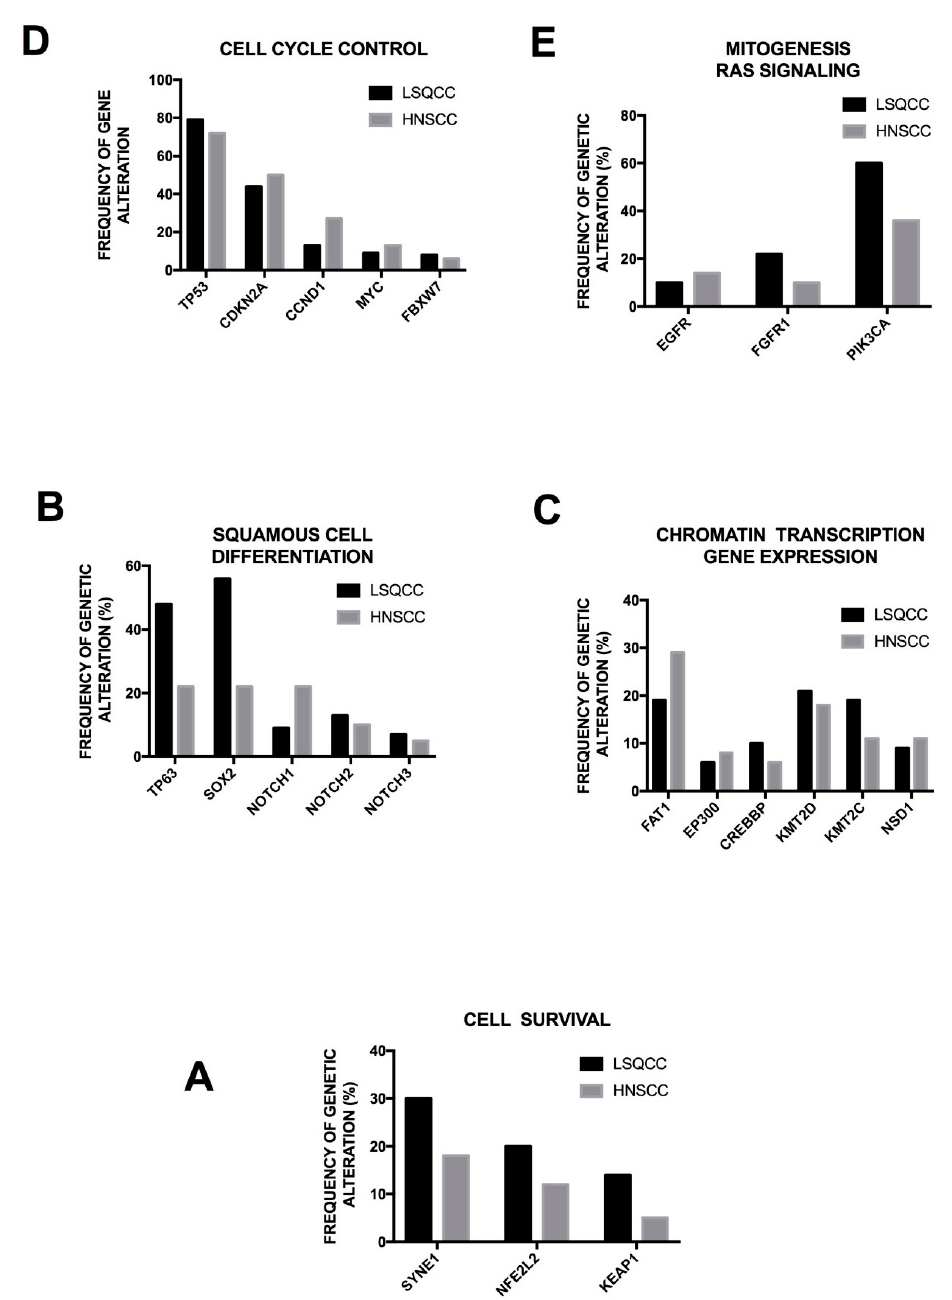
Figure 3. Pattern of frequently altered genes in LSQCC and HNSCC, subdivided according to their biologic function. A: Cell Survival; B: Squamous Cell Differentiation; C. Chromatin Transcription Gene Expression; D: Cell Cycle Control; E: Mitogenesis, RAS Signaling. Data are reported in [85].